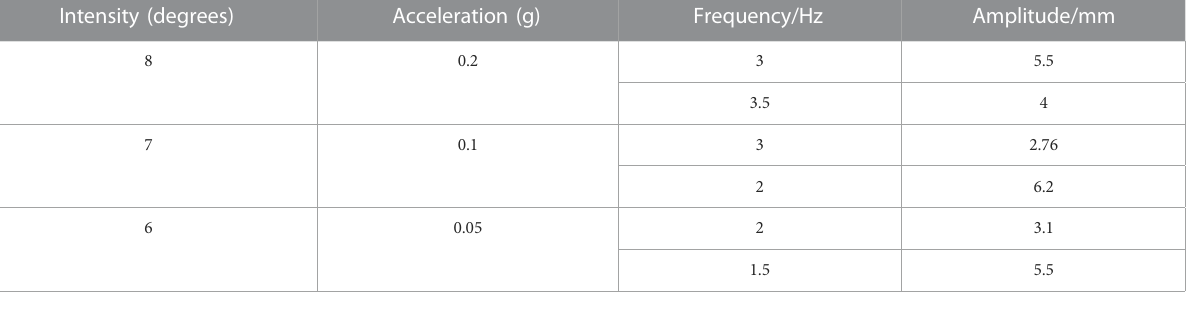
TABLE 1 Frequency and amplitude of the sine wave. Intensity (degrees)